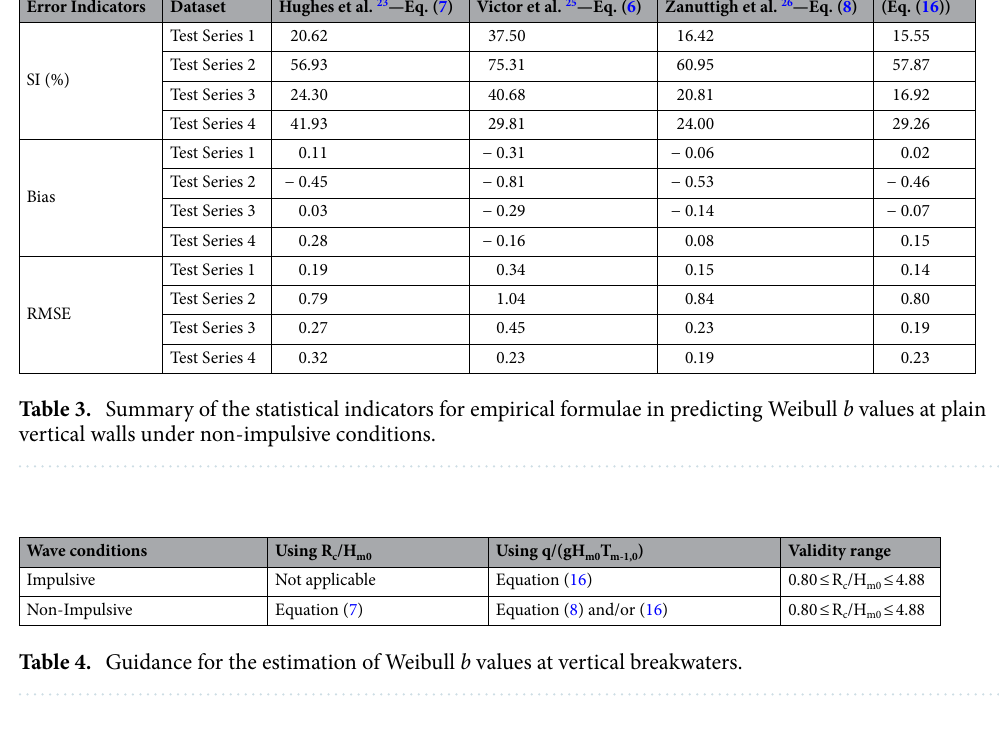
Error Indicators Dataset